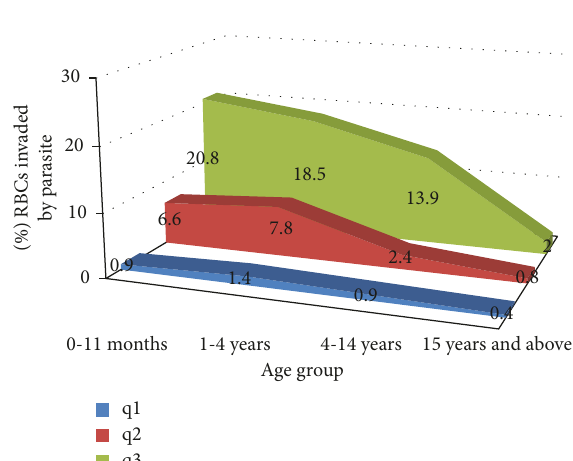
Figure 1: Scatter plot of parasite density for the study